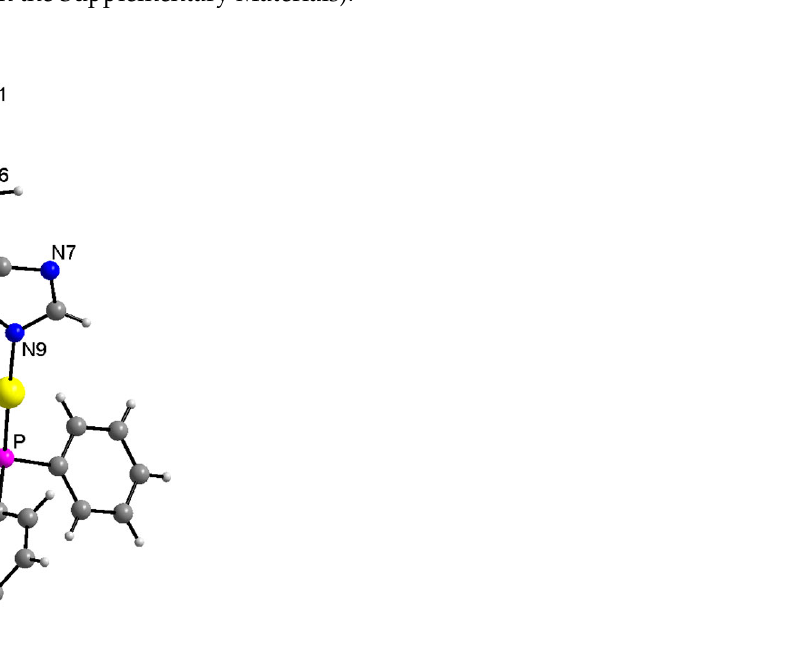
Table 1. Selected bond lengths (Å) and angles (°) for [Au(kin)(PPh 3 )] ( 1 ) and their comparison with similar Au(I) complexes containing O ‐ ethyl ‐ 7 ‐ deazahypoxanthine (HL1) and O ‐ propyl ‐ 7 ‐ deazahy ‐ poxanthine (HL2).